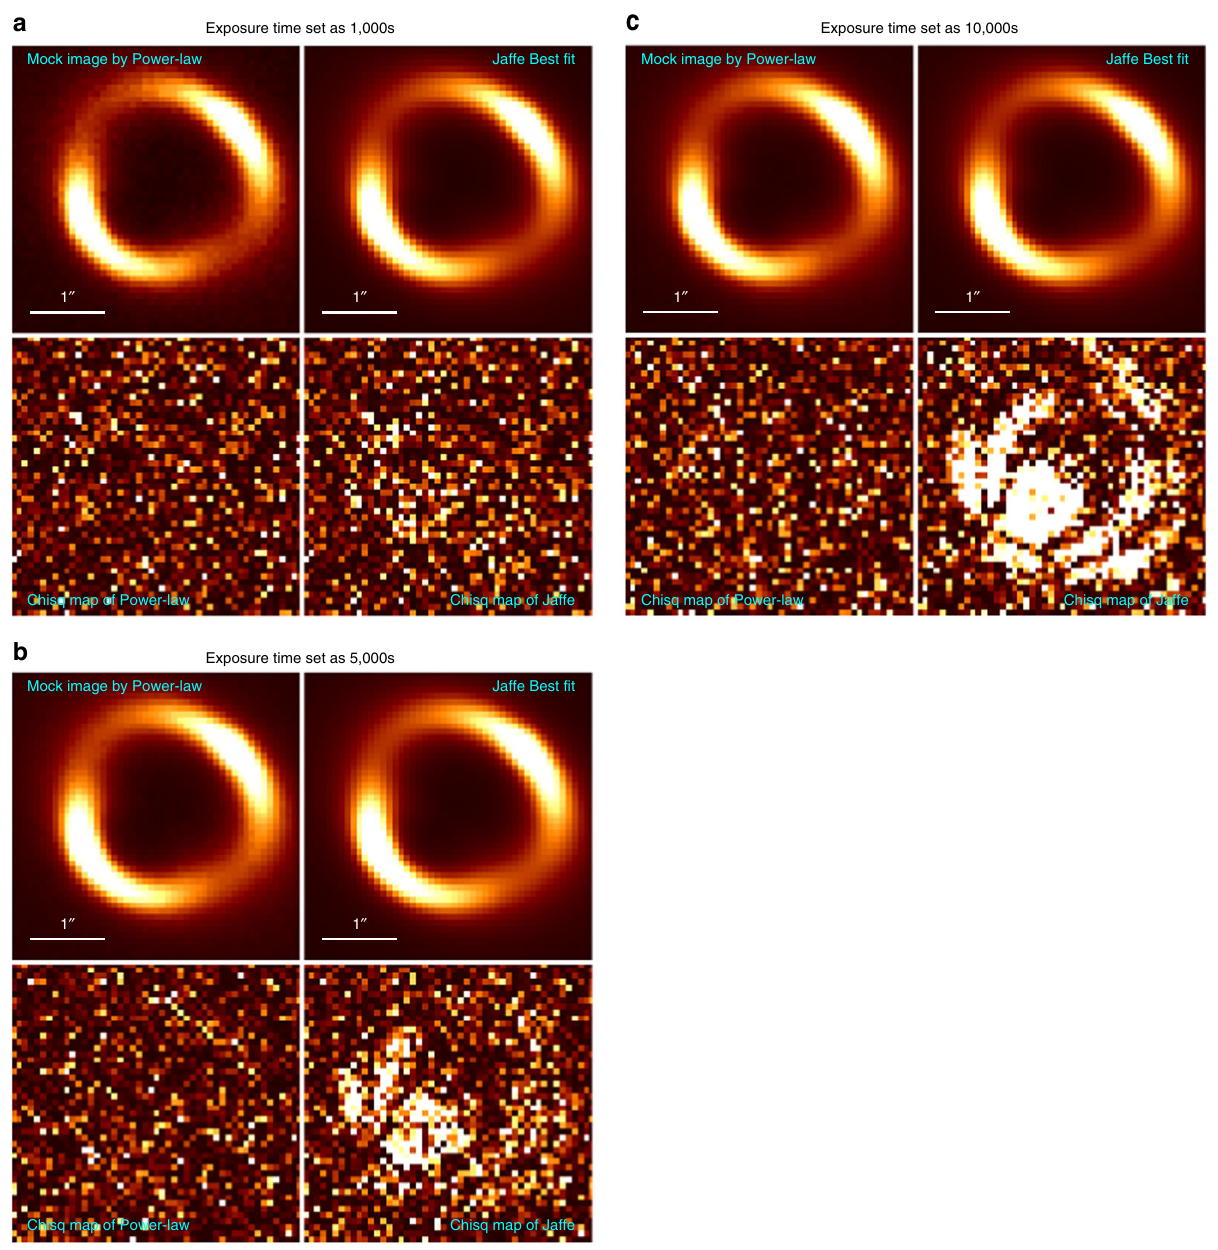
Fig. 5 Results of the simulation tests by generating the lensed arc with a power-law mass distribution model but fi tting with the Jaffe